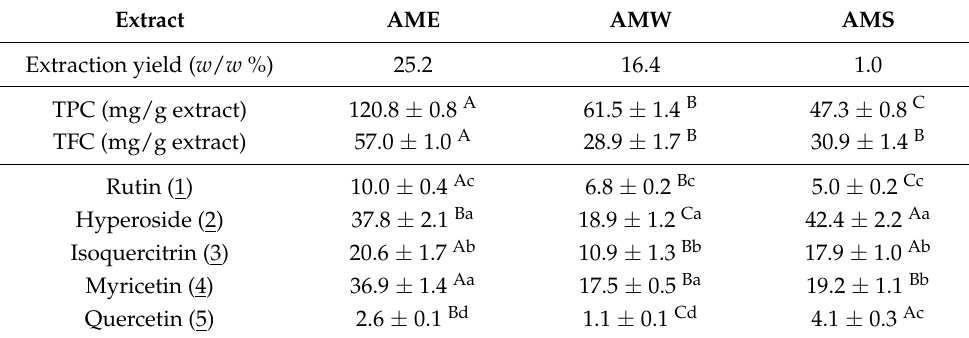
Table 2. Extraction yield and chemical composition of the three AMf extracts *. Extract AME AMW AMS Extraction yield ( w / w